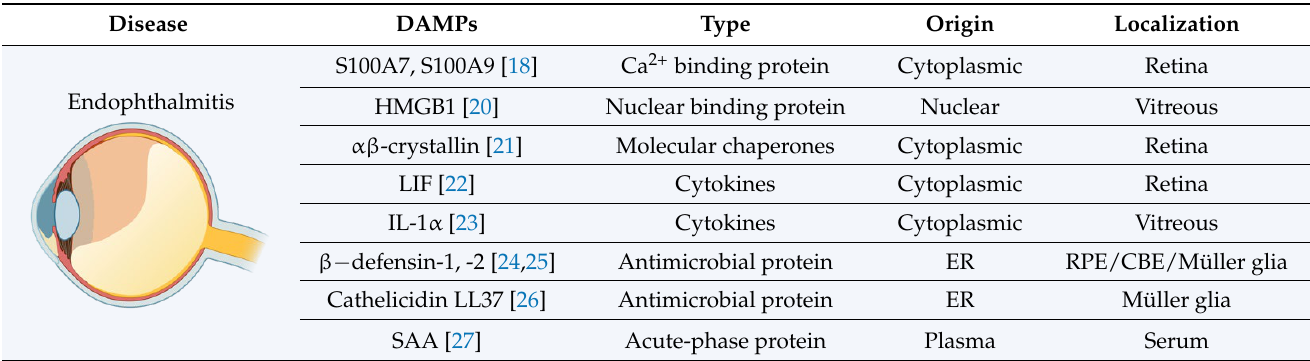
Table 1. DAMPs in endophthalmitis.